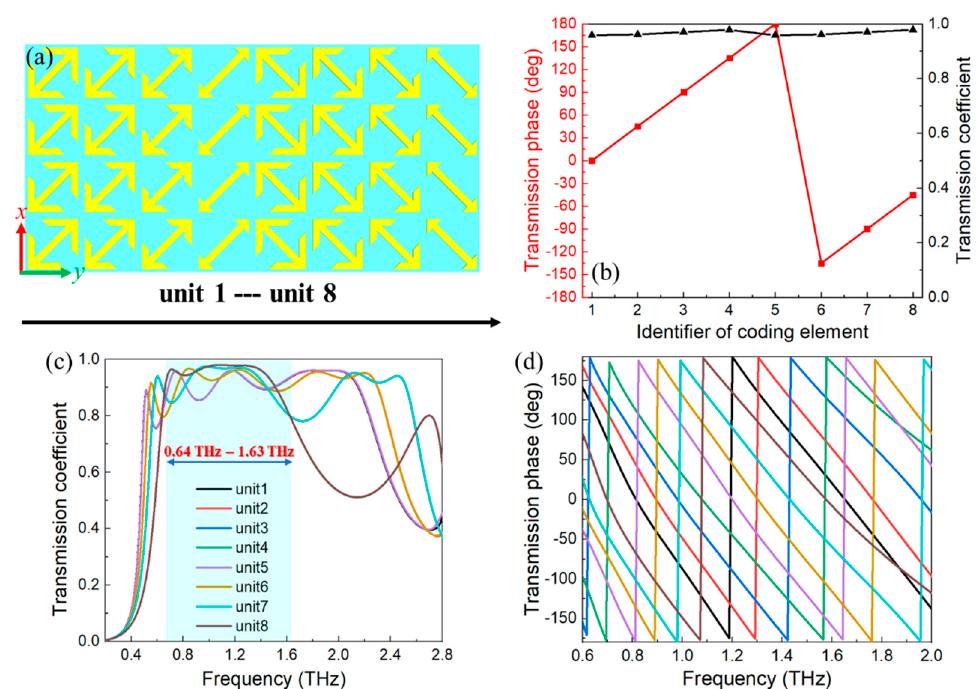
Figure 4. ( a ) The schematic of designed anomalous refractor (only the middle layer is depicted for clarity). ( b ) The transmission coefficients and phase of cross ‐ polarized THz wave for units 1 to 8 at clarity). ( b ) The transmission coefficients and phase of cross-polarized THz wave for units 1 to 8 at 1.2 THz. ( c , d ) The transmission coefficients and phase delay of cross ‐ polarized THz wave for units 1.2 THz. ( c , d ) The transmission coefficients and phase delay of cross-polarized THz wave for units 1 to 8, respectively.